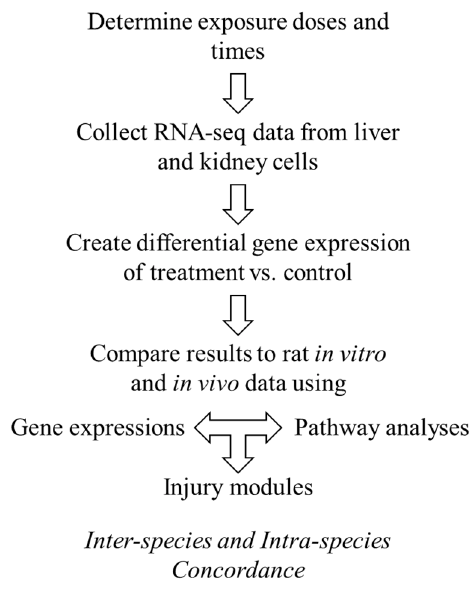
Figure 1. Diagram for comparing inter- and intra-species in vitro and in vivo cellular responses to low levels of thioacetamide exposures.